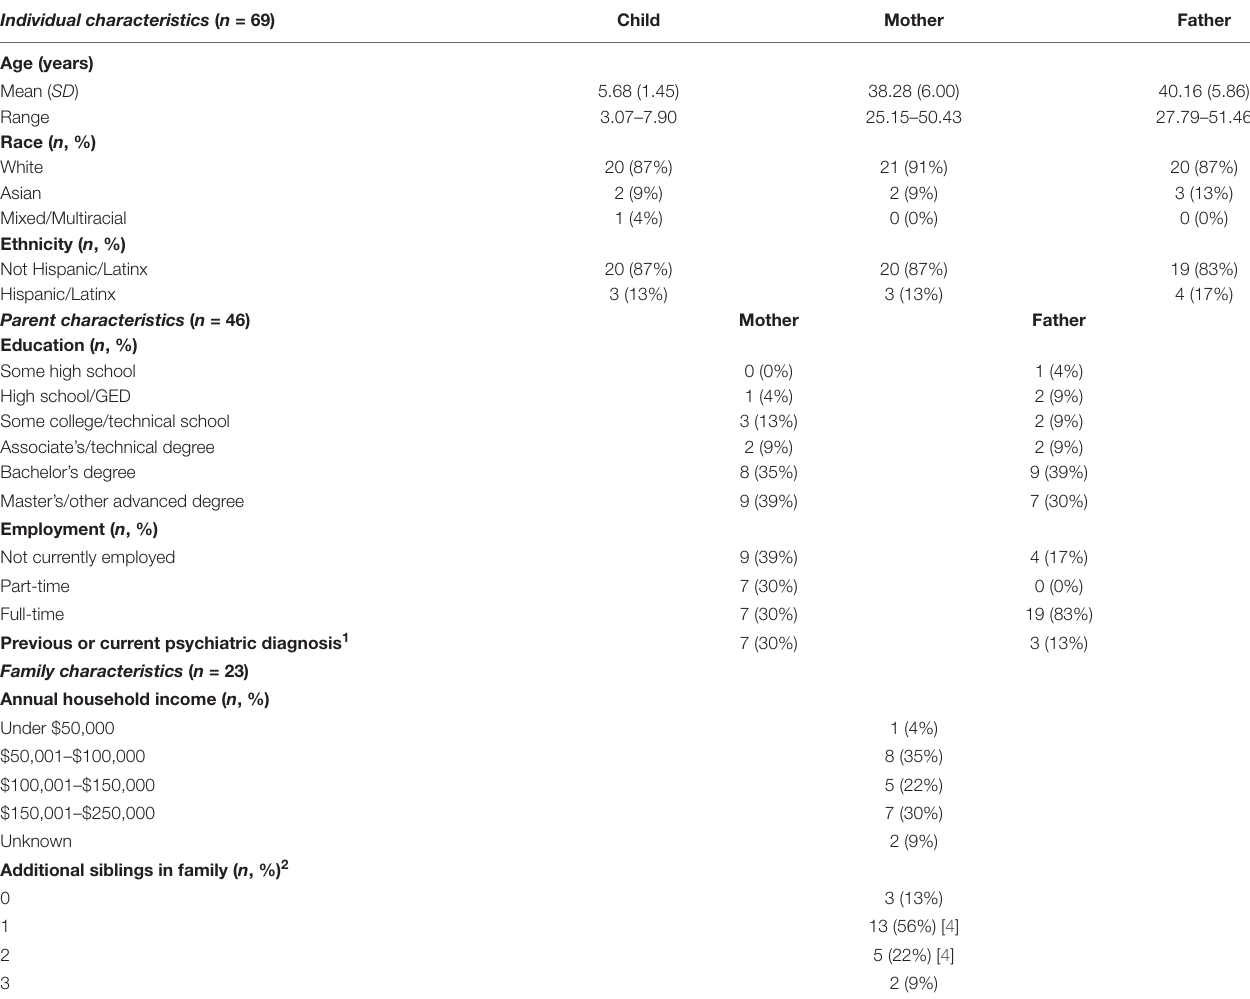
TABLE 1 | Family demographic